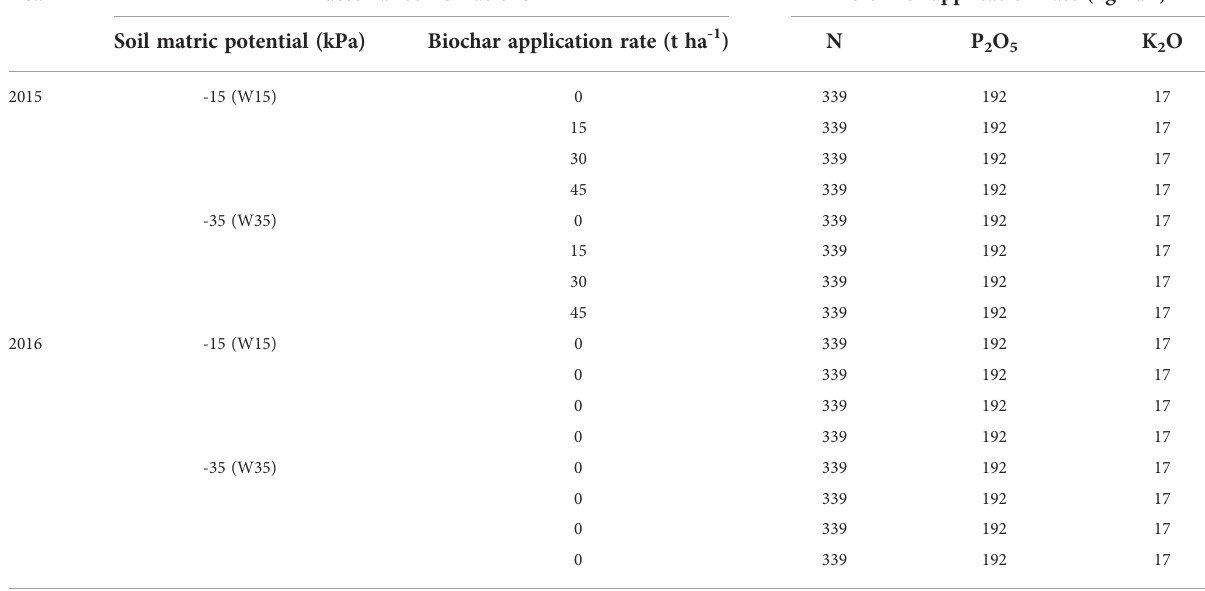
TABLE 1 Irrigation trigger points, biochar, and fertilizer application rate for all treatments.